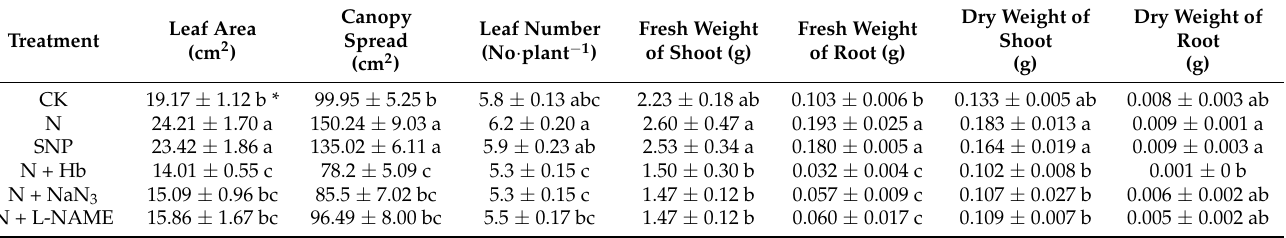
Table 1. Effects of exogenous nitric oxide, different ammonium/nitrate ratios, and the application of NO scavenger and biosynthesis inhibitors in ammonium/nitrate solution on growth parameters and biomass in Brassica pekinesis exposed to low-light stress.